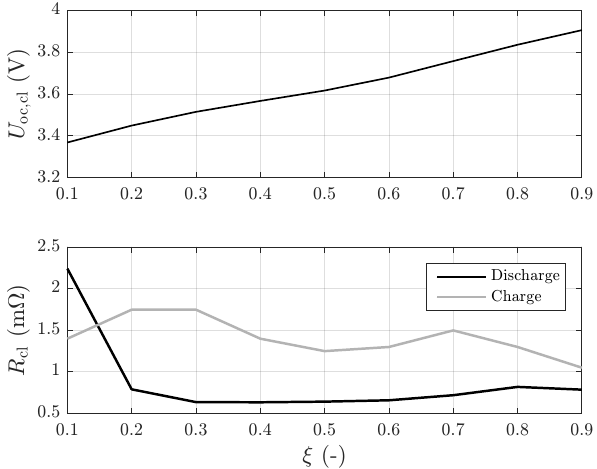
Figure 4. Data on open-circuit voltage ( U oc,cl ) and internal resistance ( R cl ) for the base battery cell used